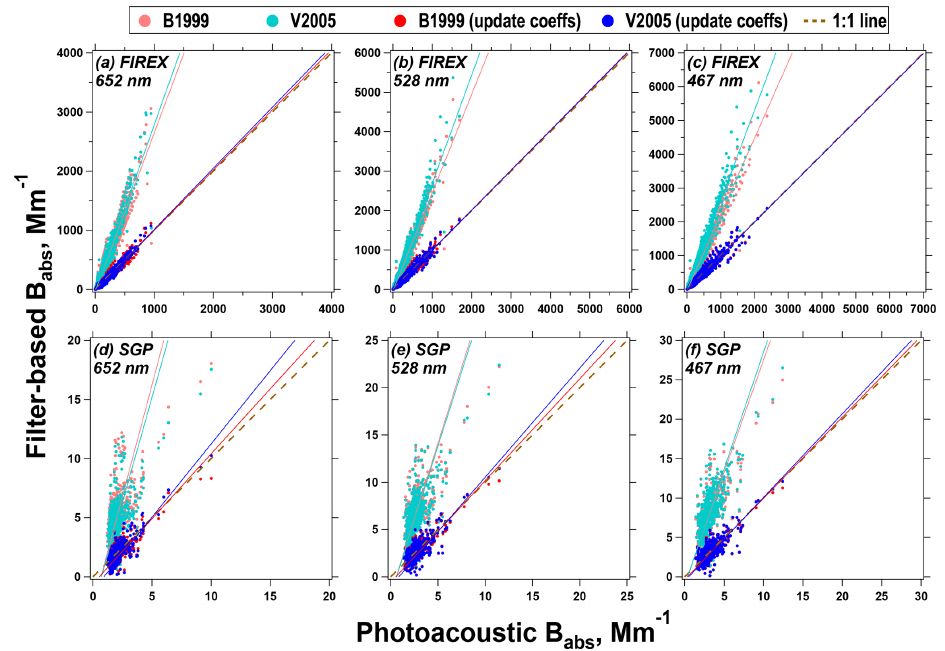
Figure 2. Intercomparison between the CLAP-derived B abs corrected by the B1999 and V2005 algorithms and the reference B abs at 652, 528, and 467nm for both FIREX and SGP data. The solid lines represent linear regressions, while the dashed line is a 1 : 1 line.